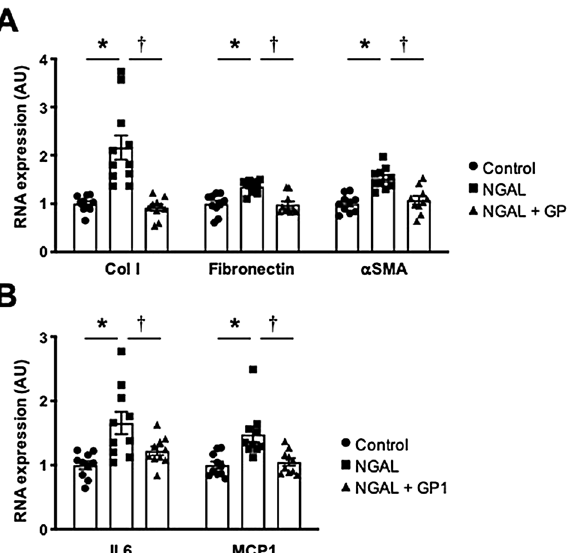
Figure 3. Effect of GP1 (GPZ614741), at 10 µM, on mRNA levels of ( A ) profibrotic markers Col I, fibronectin and αSMA) and ( B ) proinflammatory markers (IL6 and MCP1) in mNGAL-treated MKF cells. *p < 0.05 vs . Control. † p < 0.05 vs. NGAL-treated MKF